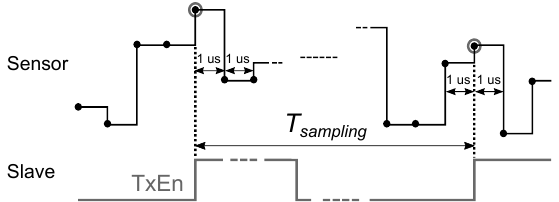
Figure 14. Capturing of the sensor values at the rising edges of the transmit enable (TxEn) signal with the sampling step T sampling